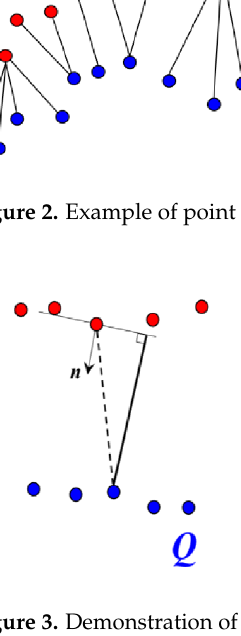
Figure 3. Demonstration of point-to-plane ICP. Dashed line shows the point correspondence and the solid line shows the projection along the surface normal